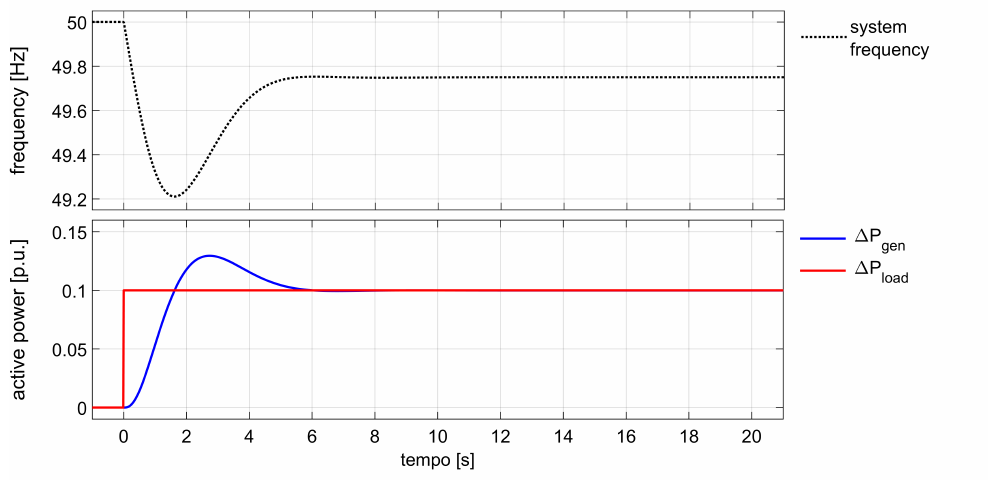
Figure 4. Frequency and active power trajectories without SI